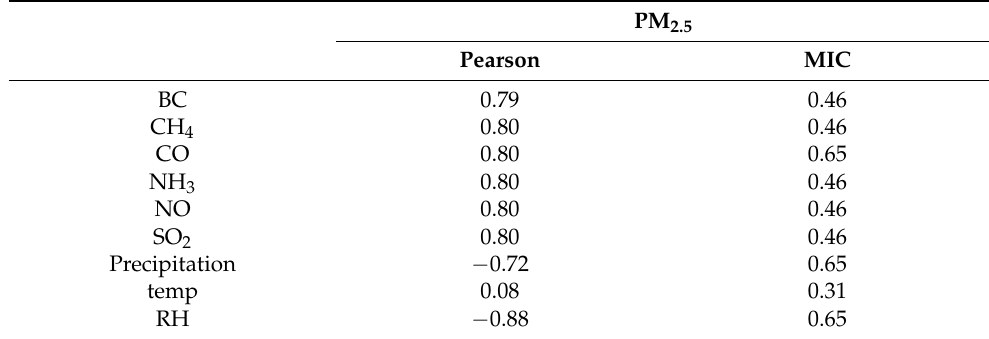
Table 3. Correlation between PM 2.5 and emission data and climate parameter during 2020–2029.